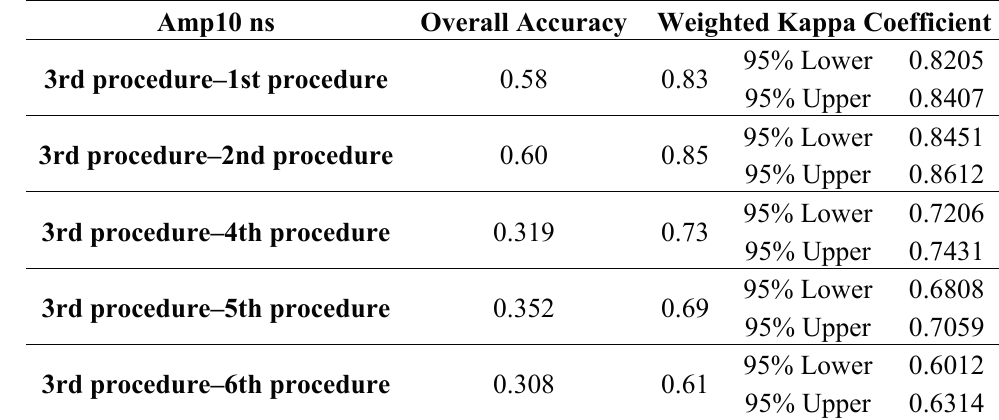
Table 2. Overall accuracy and kappa coefficient with its 95% Lower and Upper confidence limits between the time slices related to 10 ns for 250 MHz frequency obtained with different procedures and compared with the reference procedure (third